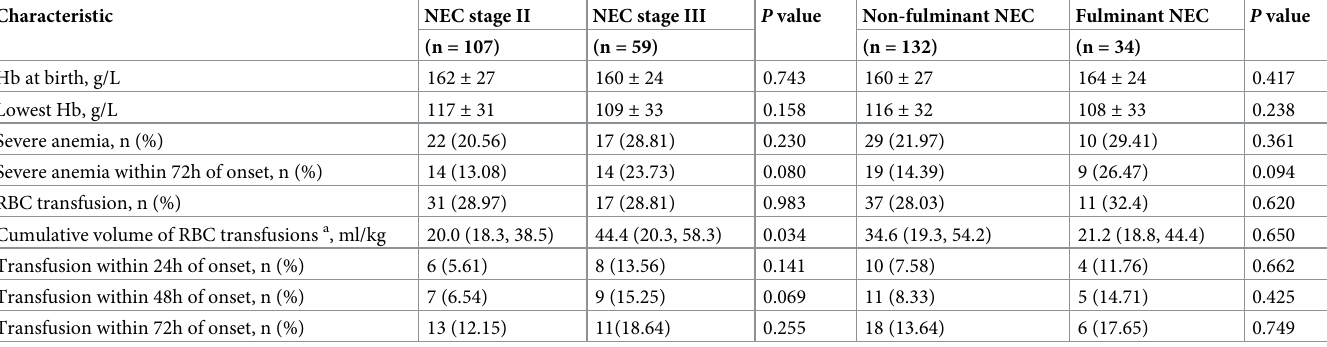
Table 3. Characteristics of different degree of NEC and fulminant NEC in very low birth weight infants.